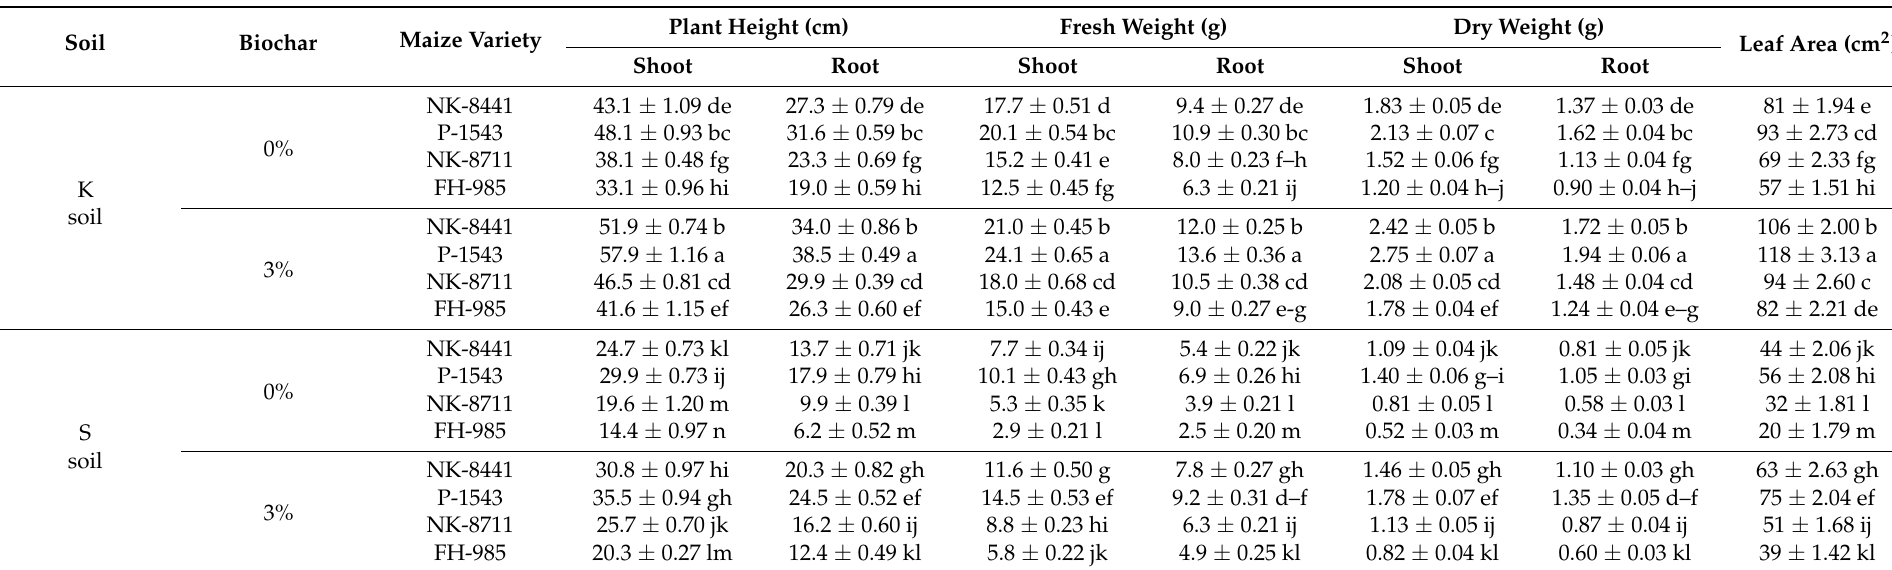
The values are mean ± S.E. (n = 3). Mean values with different alphabetical letters are significantly different ( p < 0.05) according to Tukey’s HSD test; K: Kasur soil; S: Sialkot